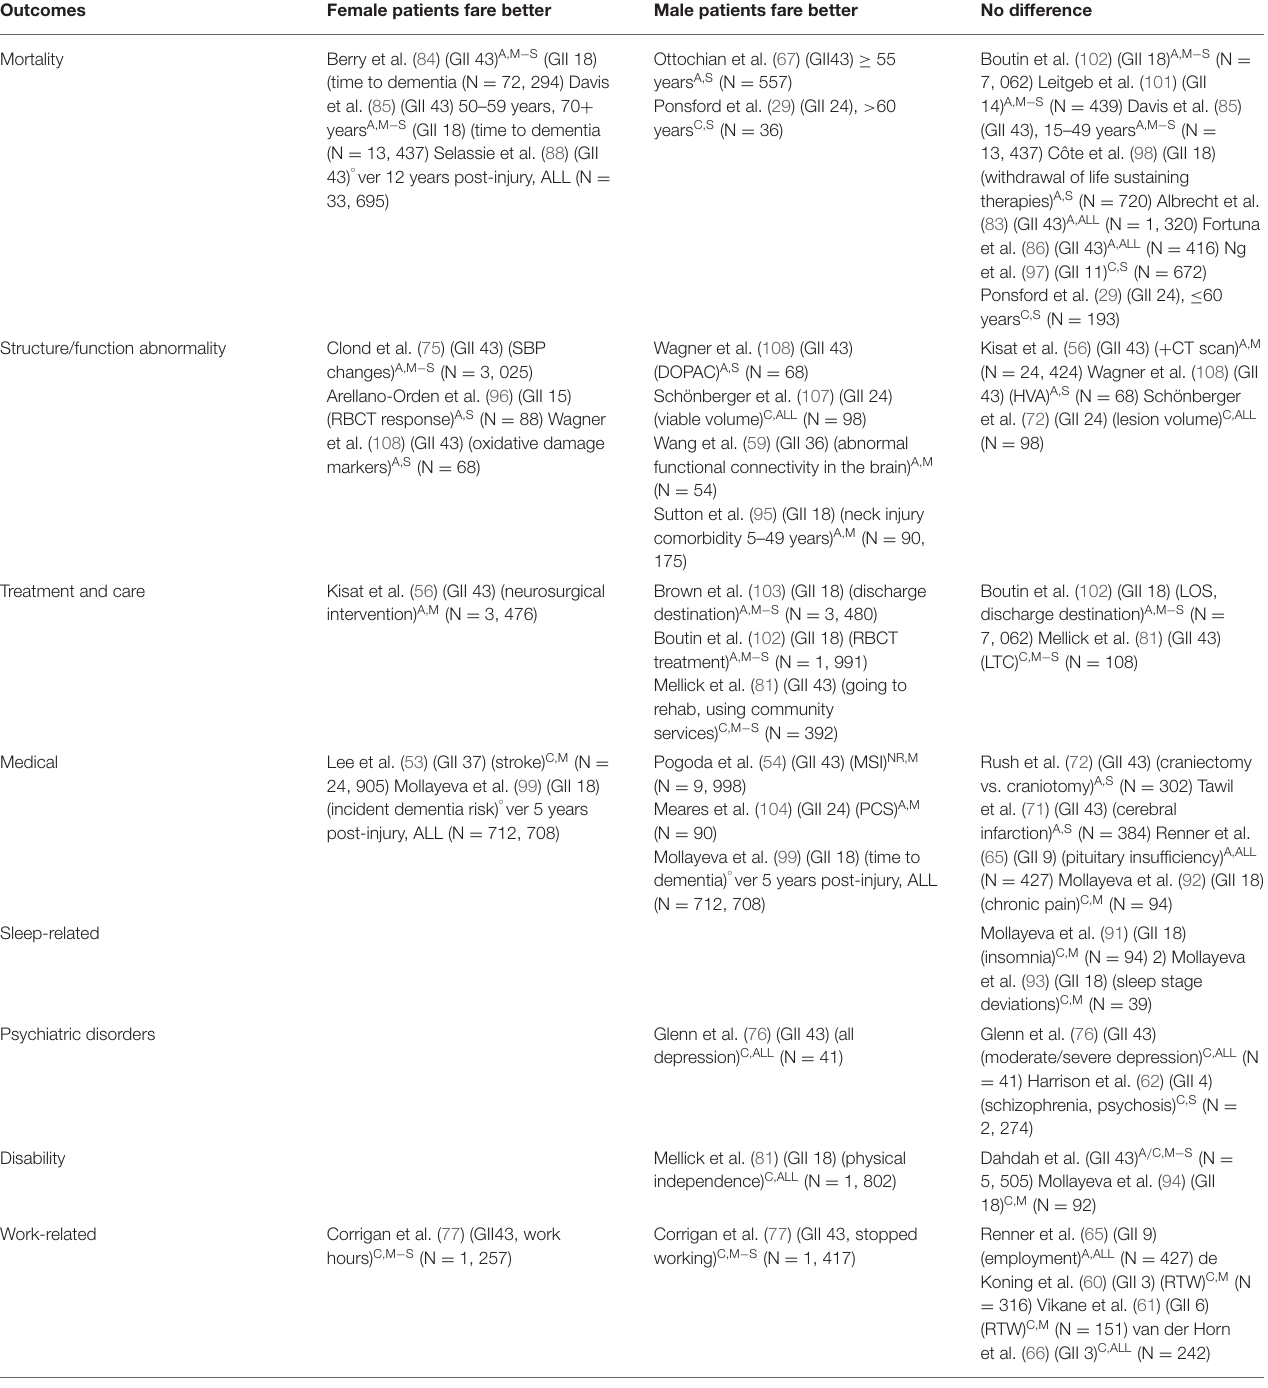
TABLE 2 | Review findings: differences in outcomes of male and female persons after